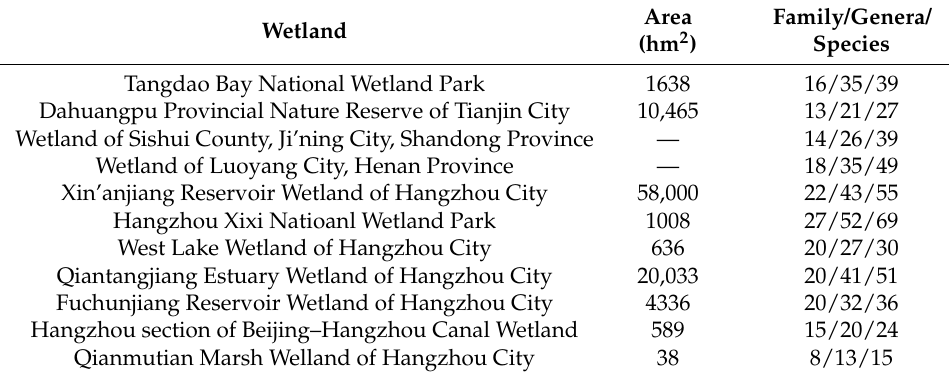
Table 5. Comparison of the number of alien invasive plant species in the Tangdao Bay National Wetland Park with those of other wetland examples in China. Area Family/Genera/ Wetland (hm 2 ) Species Tangdao Bay National Wetland Park 1638 16/35/39 10,465 13/21/27 — 14/26/39 Wetland of Luoyang City, Henan Province — 18/35/49 Xin’anjiang Reservoir Wetland of Hangzhou City 58,000 22/43/55 1008 27/52/69 West Lake Wetland of Hangzhou City 636 20/27/30 20,033 20/41/51 4336 20/32/36 589 15/20/24 38